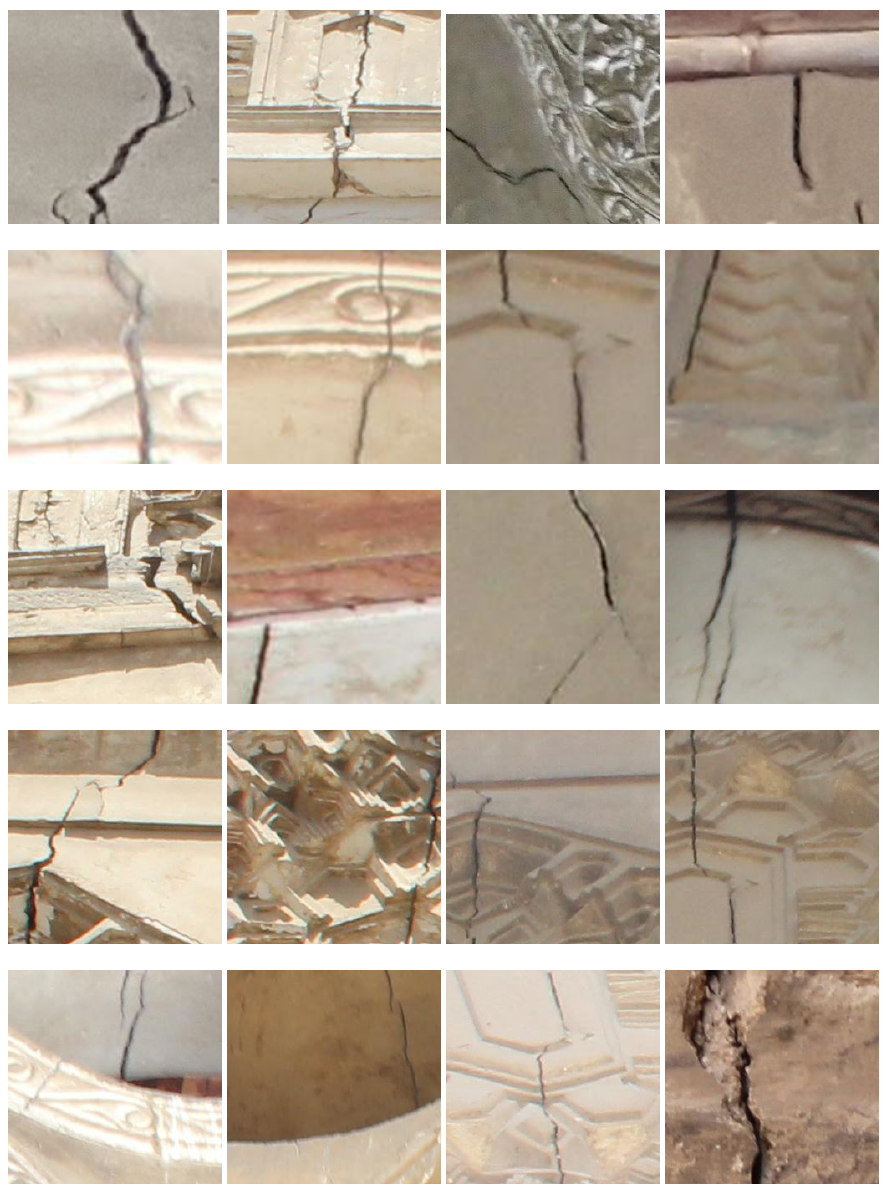
Figure 3. Samples of cracks in the primary